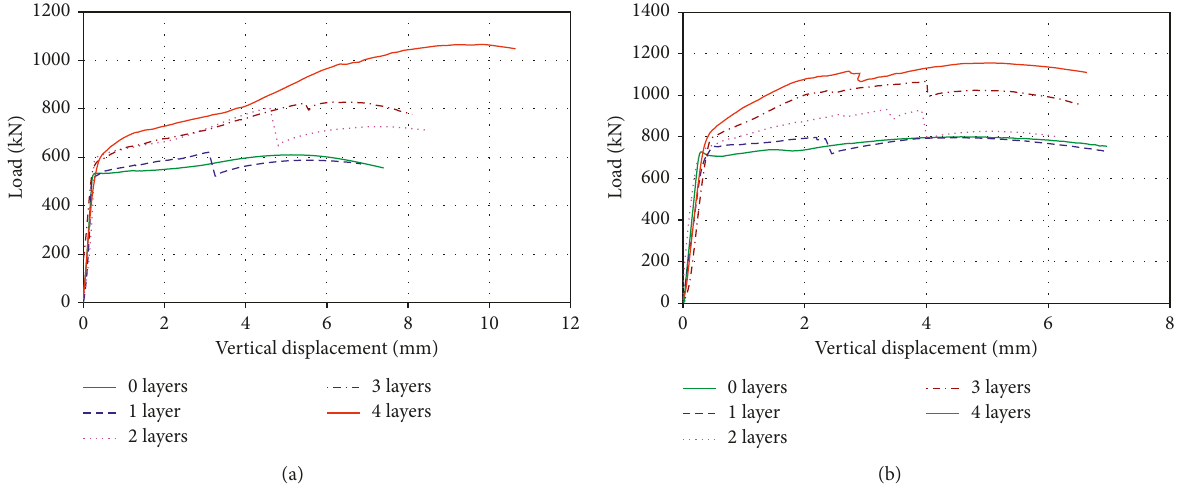
Figure 8: Load/displacement curves: effects of the number of layers. (a) Series I. (b) Series II.